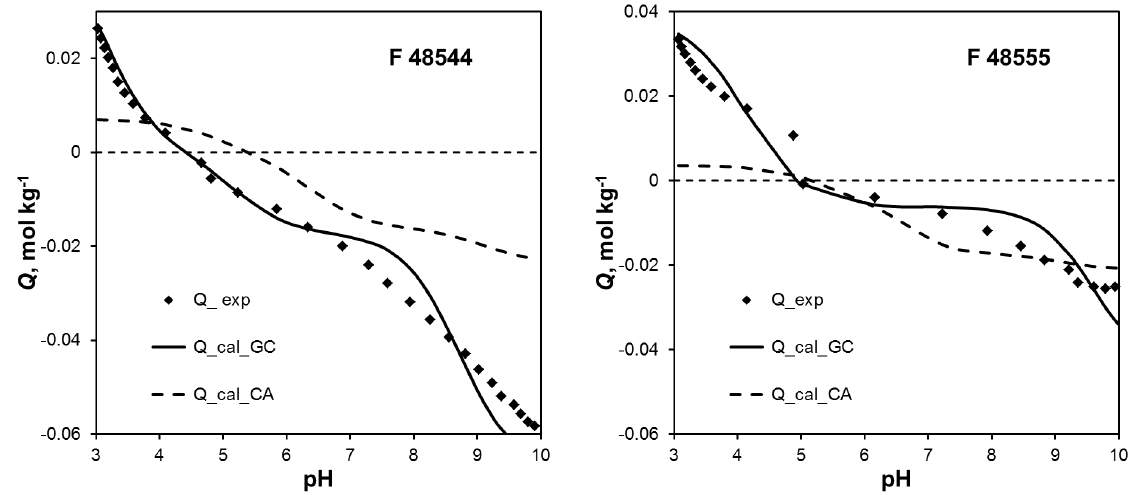
Figure 2: MA - Fucoidic sandstone samples (48544, 48555) – titration curves evaluated using GC- and CA-approach method.